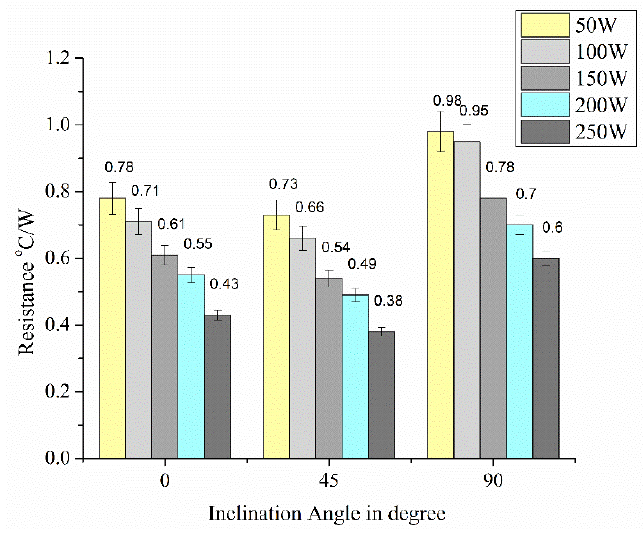
Figure 3. Thermal Resistance with UAS Vs Inclination angle.